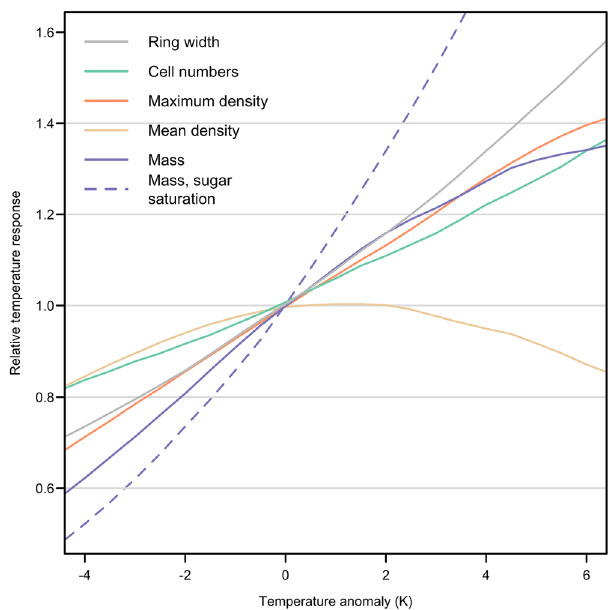
Fig.5|Temperatureeffectsonsimulatedgrowthin Pinussylvestris L.atthesite used in Fig. 2, 1995. Each line is the running mean for 100 radial fi les of the variable ’ s response over a 1.5 K-wide window (i.e. across three 0.5K increments). Temperature anomaly applied as a step increment to the observed daily values used to compute cell enlargement and wall